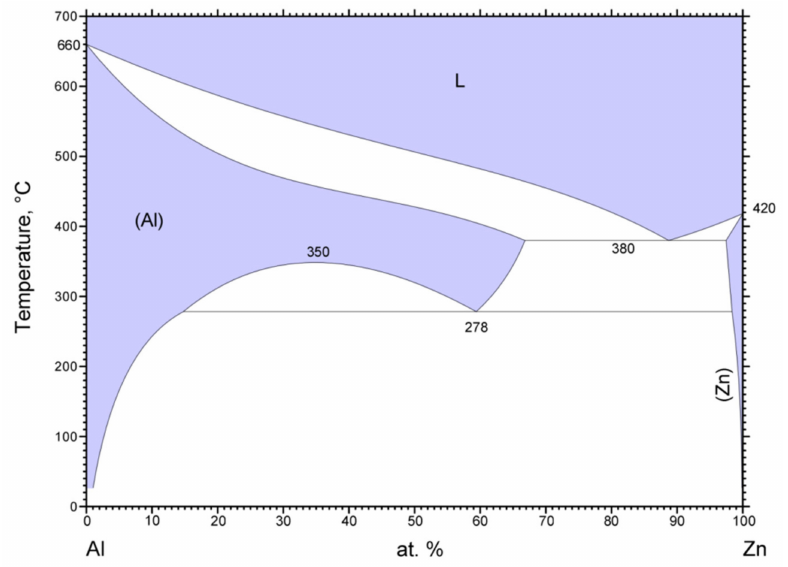
Figure 6. The binary diagram of Al–Zn